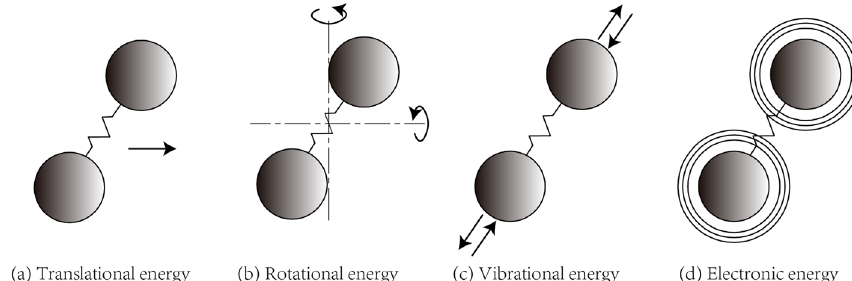
Fig. 10 Energy modes for a diatomic molecule